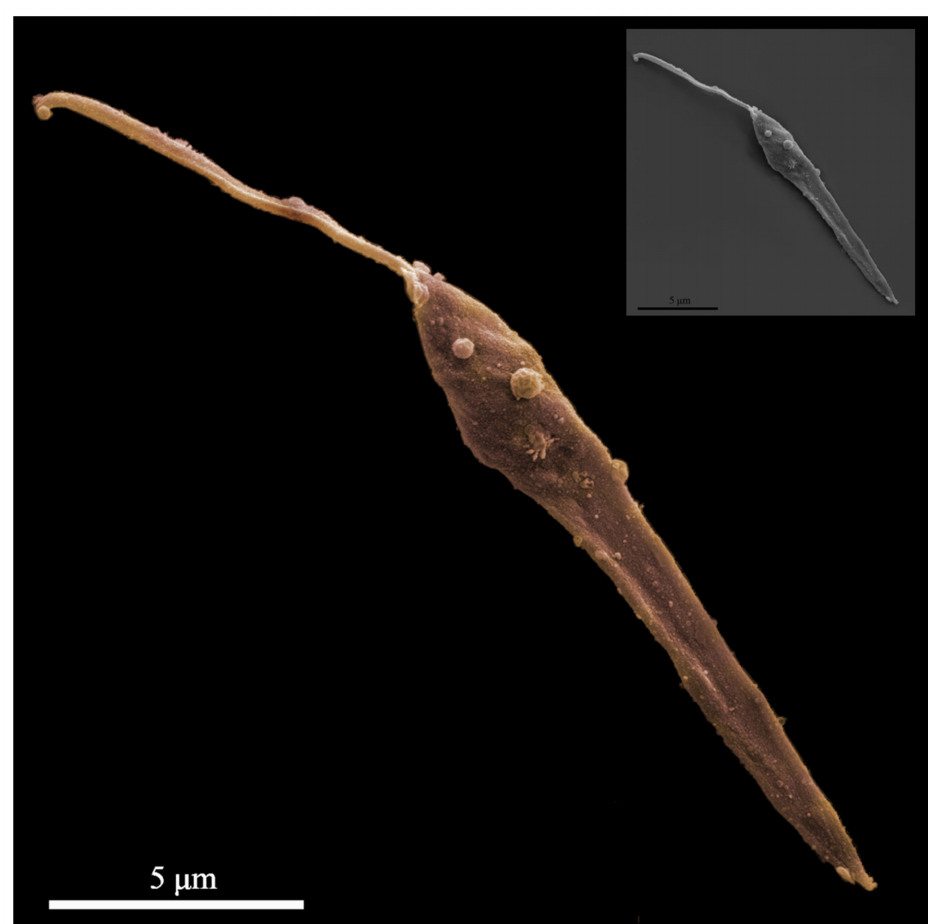
Figure 4. Heterogeneous group of membrane-bound extracellular vesicles secreted by Leishmania . Representative SEM photomicrograph showing surface membrane vesicular forms (light points, rounded and amorphous vesicles) of L. ( L .) amazonensis promastigotes (MHOM/BR/2009/M26361 strain). Scale-bar 5 µ